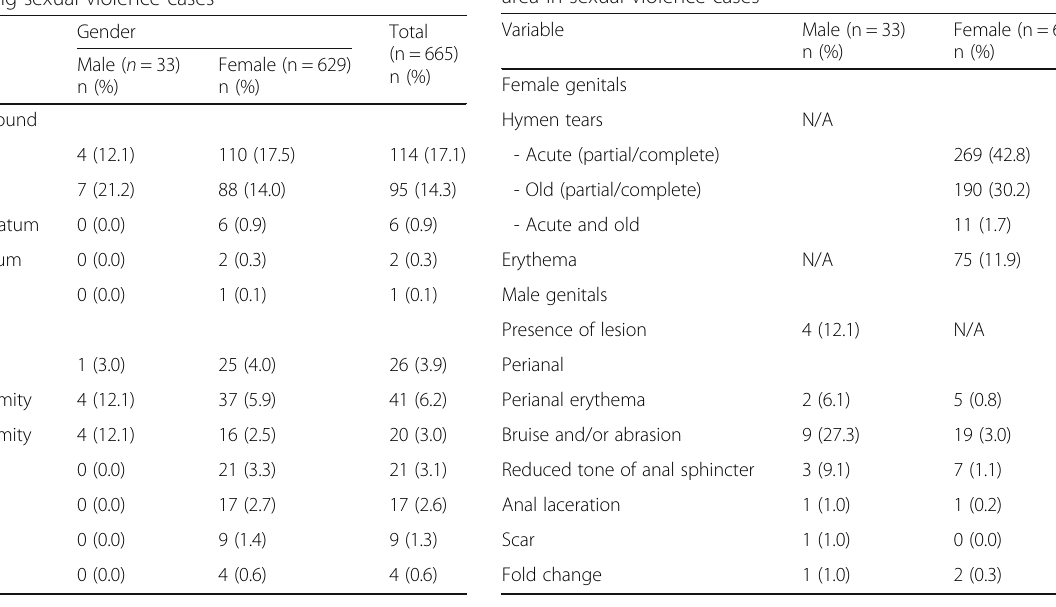
Table 4 Forensic examination findings of the